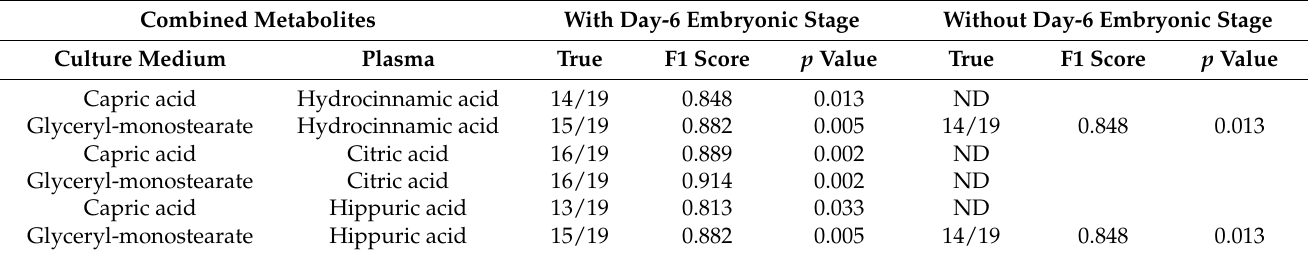
Table 5. Targeted validation (GC-MS) at birth by F1 score (with or without separation of blastocyst and morula as Day-6 embryonic stages) of metabolite pairs selected in embryo culture medium ( N = 19) and Holstein recipient Day-0 plasma ( N =